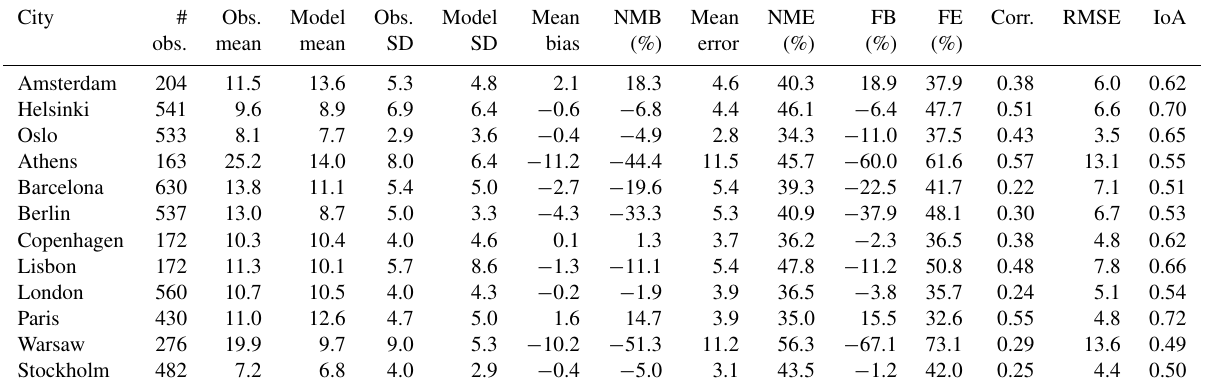
Table 4. Summary of CAMx model performance evaluated at background AirBase sites belonging to the selected cities. Statistics are computed for daily mean PM 2 . 5 concentrations over the summer season (1 July–30 September). City # Obs. Model